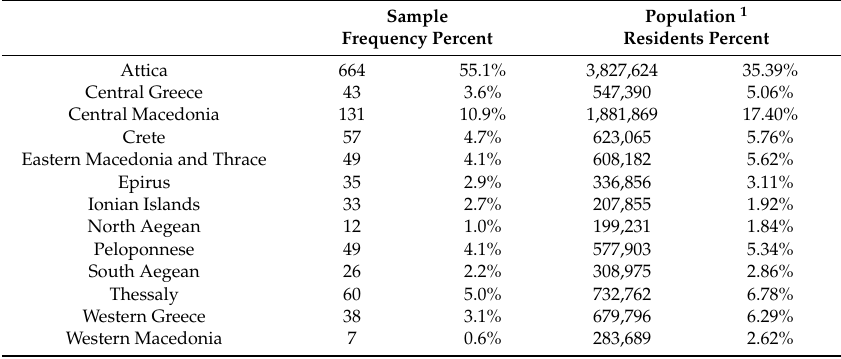
Table 1. Sample distribution per